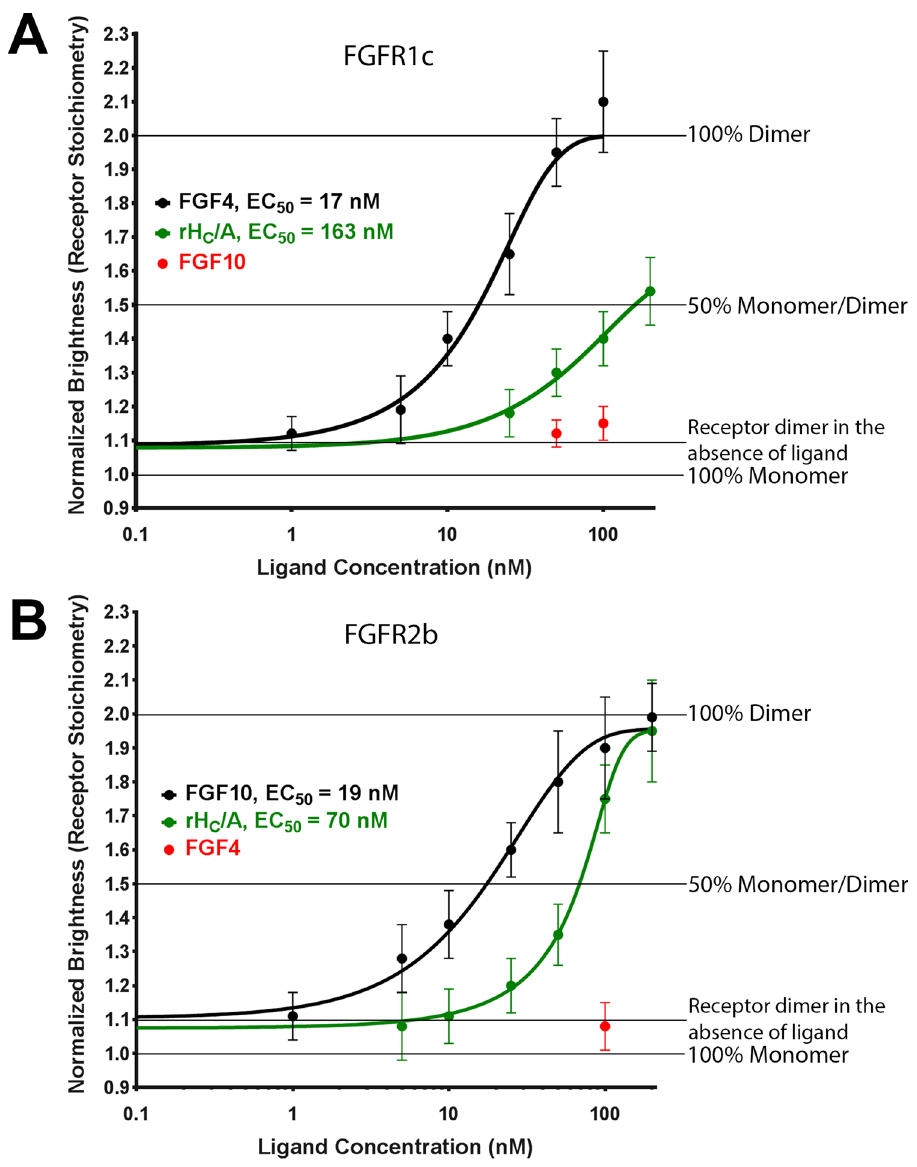
Figure 5. FGFR binding preference of rH C /A. (A) BoNT/A binding domain (rHC/A) (green) dimerizes fluorescently tagged FGFR1c with reduced potency compared to fluorescently tagged FGFR3c, EC 50 163 nM (95% CI; 131, 202)* vs 27 nM (95% CI; 18, 41) (Fig. 3) . A known native FGFR1c ligand, FGF4 (black) (positive control), dimerizes FGFR1c, EC 50 = 17 nM [95% CI; 8, 35], while a known native FGFR2b ligand, FGF10 (red), does not. Points represent the average normalized brightness values ± SD from greater than 20 cells collected on 4 independent days. (B) BoNT/A binding domain (rH C /A) (green) dimerizes fluorescently tagged FGFR2b with reduced potency compared to fluorescently tagged FGFR3c, EC 50 70 nM (95% CI; 59, 82) vs 27 nM (95% CI; 18, 41) (Fig. 3), respectively. A known native FGFR2b ligand, FGF10 (black) (positive control), dimerizes FGFR2b, EC 50 = 19 nM (95% CI; 13, 26), while a known native FGFR1c ligand, FGF4 (red), does not. Points represent the average normalized brightness values ± SD from greater than 30 cells collected on 4 independent days. *Based on 2PL with bottom = 1, top =